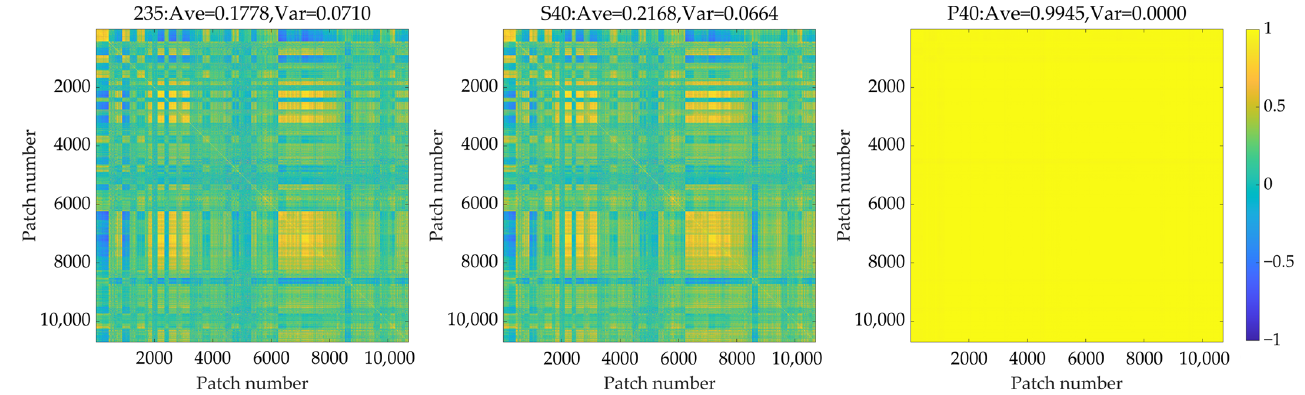
Figure 8. The correlation coefficients between patches of datasets 235, S40, and P40. To exclude the influence of the spectral dimension and get the correlation coefficients between patches in the spatial dimension, the correlation coefficients between patches can be calculated according to Equations (2)–(5). The correlation coefficients between patches of datasets 235, S40, and P40 calculated in this way are presented in Figure 9.